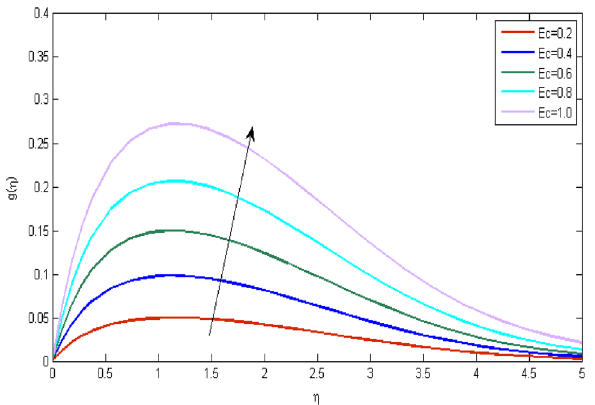
Figure 8. Ec influence on g .